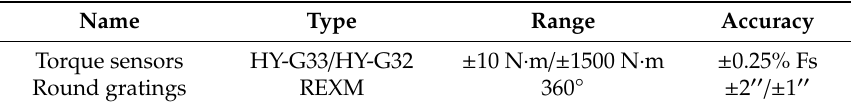
Table 3. Parameter list of sensors.